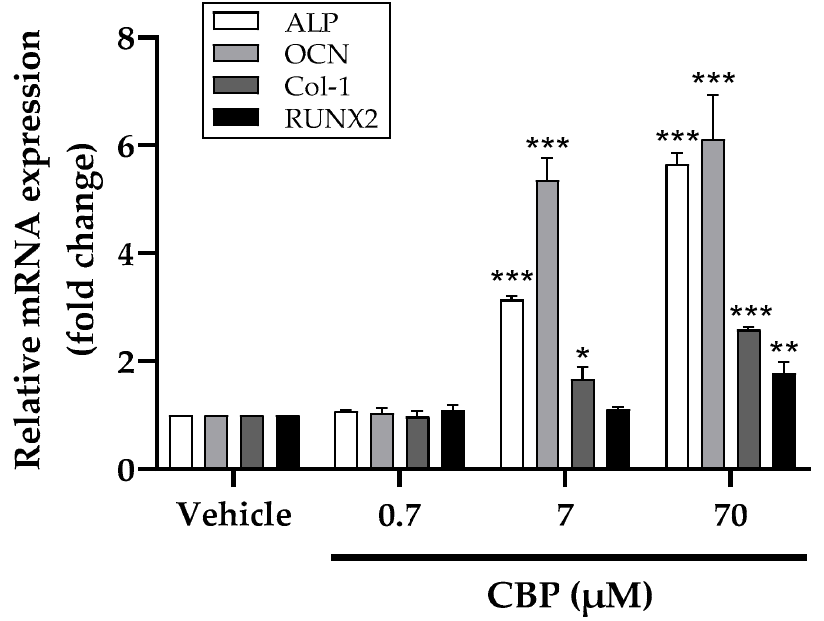
Figure 3. Effects of CBP on mRNA expression of bone formation markers (ALP, OCN, Col-1 and RUNX2) in MC3T3-E1 cells. MC3T3-E1 cells were treated with 0–70 µ M CBP for 7 days. n = 3. Data are expressed as mean ± SEM. * p < 0.05, ** p < 0.01, and *** p < 0.001 vs. vehicle.